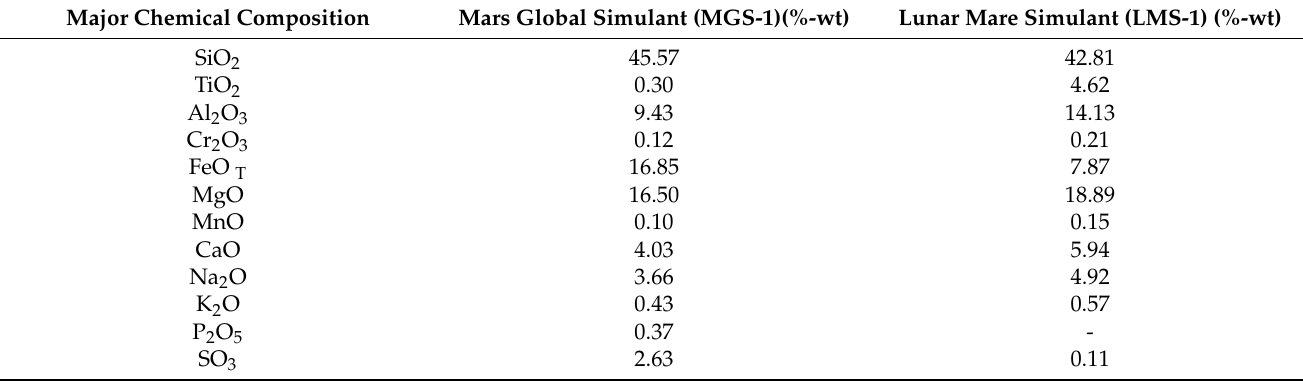
Table 1. Chemical composition of Martian and lunar regolith simulants used in this study (source: ExolithLab). Major Chemical Composition